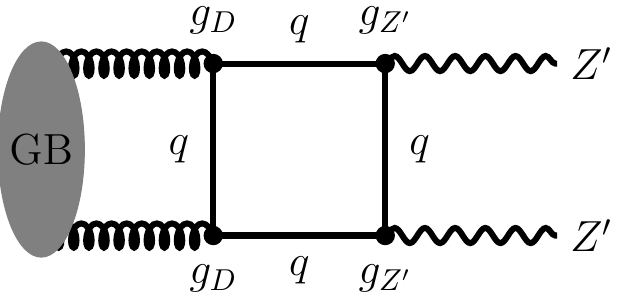
Figure 4 . The 1-loop diagram giving rise to the 0 ++ glueball decay. For the range of masses we study, the final Z 0 s are on-shell. The heavy quark loop gives rise to a suppression of (Λ /m q ) 8 in